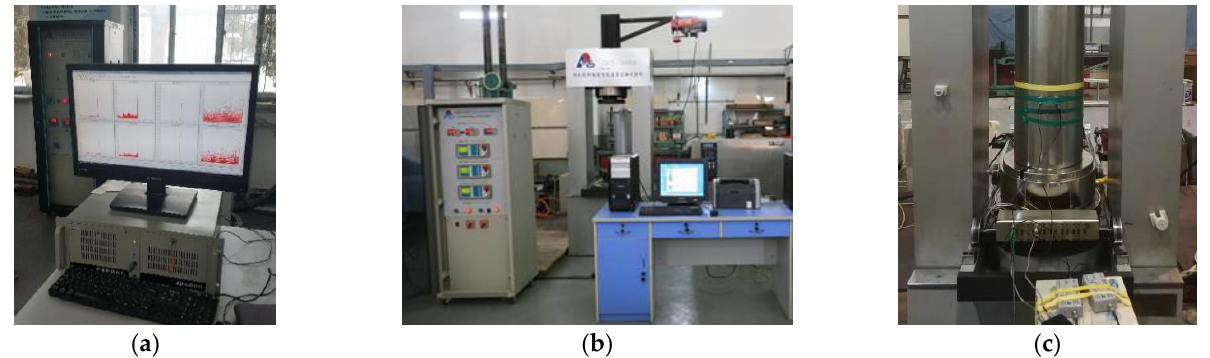
Figure 1. Rock mechanics test system and acoustic emission test layout. ( a ) PCI-II acoustic emission system; ( b ) TAW-2000 triaxial hydraulic servo testing machine; ( c ) the layout of acoustic emission monitoring probe.